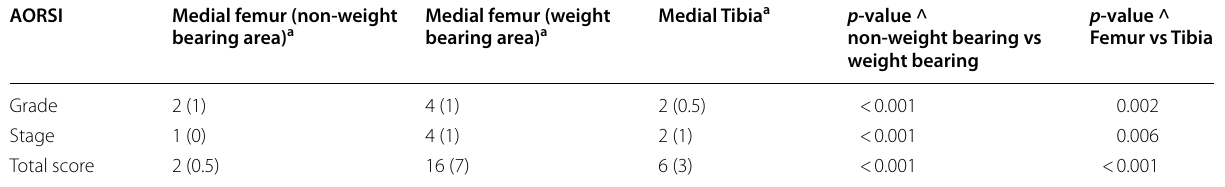
Table 1 AORSI scores, and comparison between femoral non‑weight bearing and the weight bearing area, femur, and tibial articular surfaces